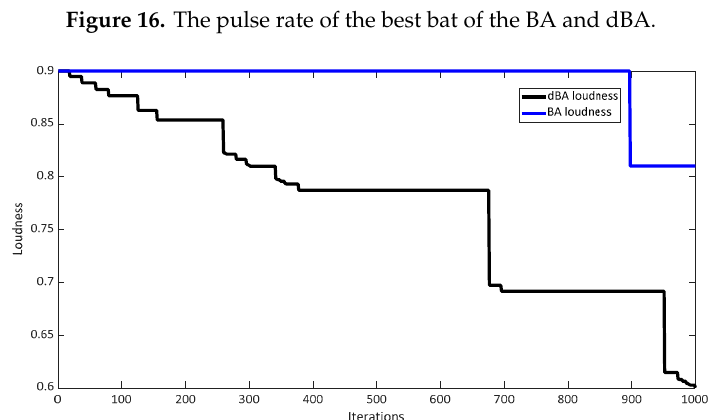
Figure 16. The pulse rate of the best bat of the BA and dBA.